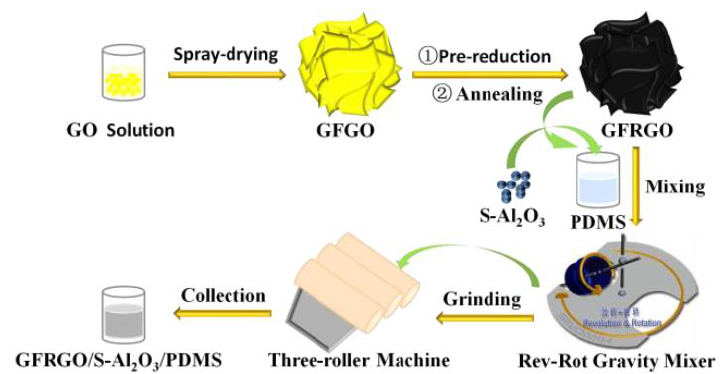
/ S-Al / PDMS 2 O 3